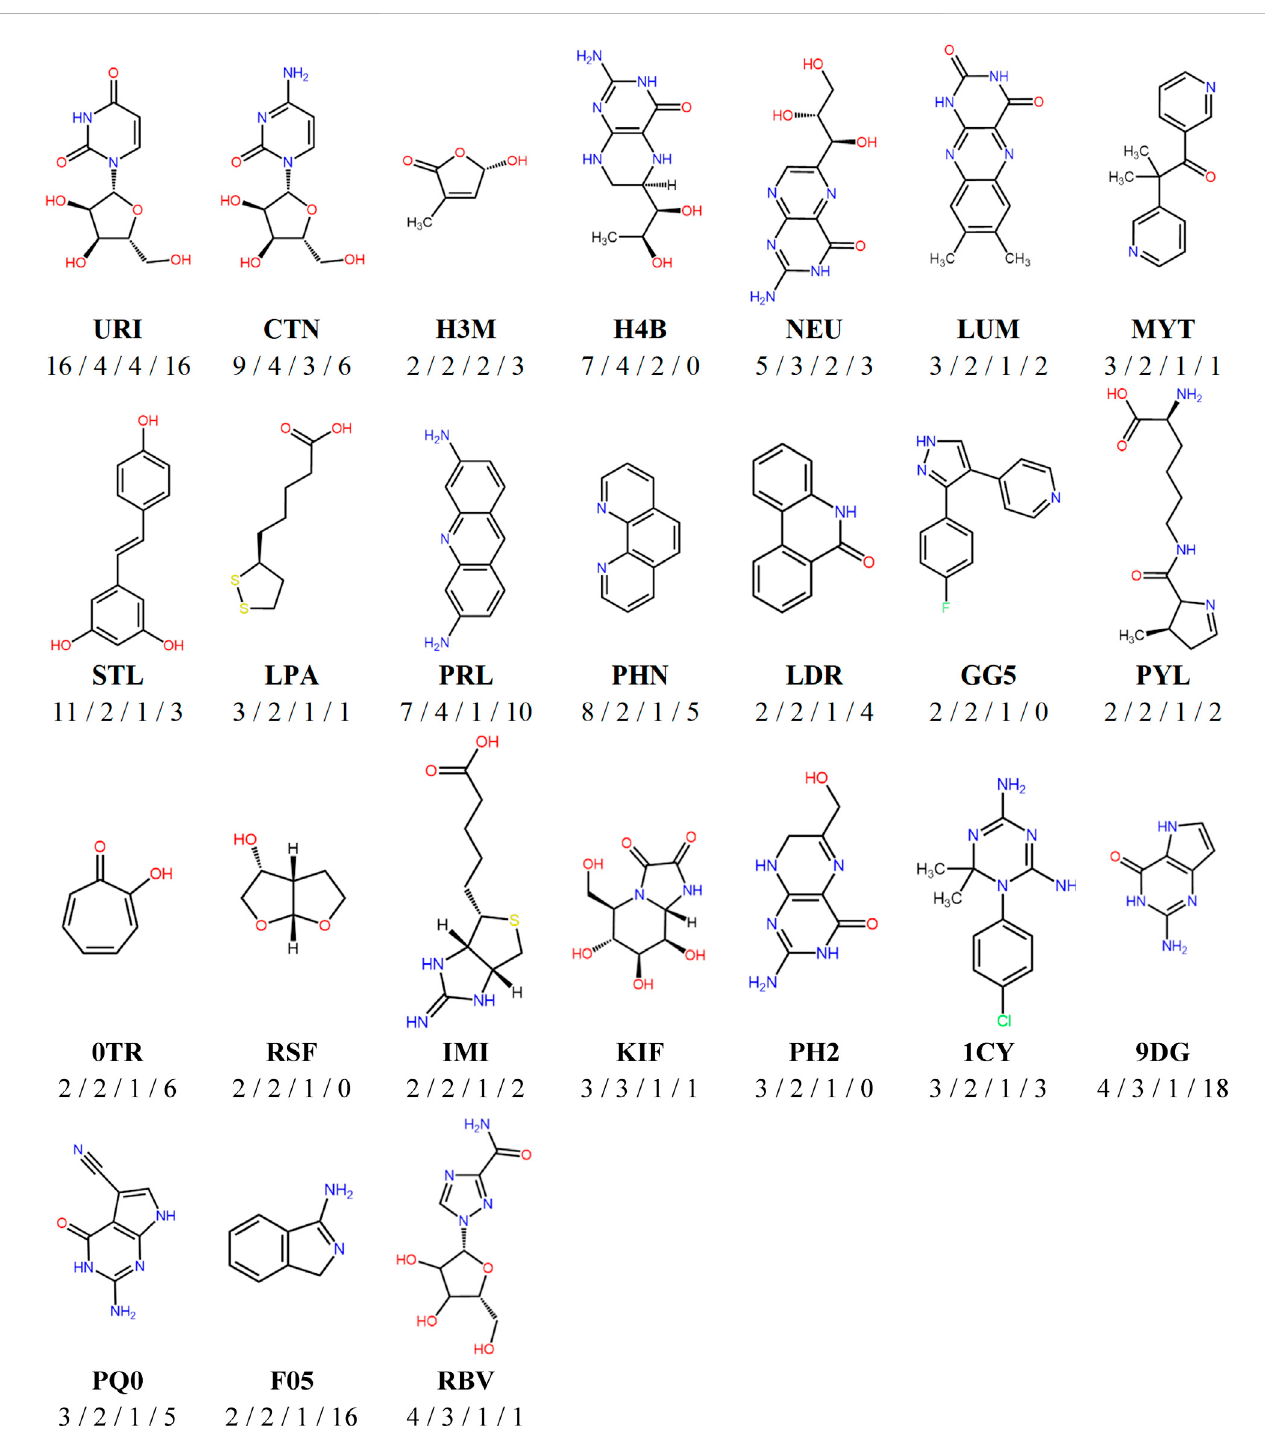
FIGURE 4 RepresentativechemicalstructuresoftheversatilePDBfragmentswhichareabsentorpoorlyrepresentedincommercialfragmentslibraries.Beloweach fragment structure are indicated the HET code, then the number of binding modes/the number of different cavities/the number of versatile PDB fragments containing the same scaffold/the number of commercial fragments containing the same